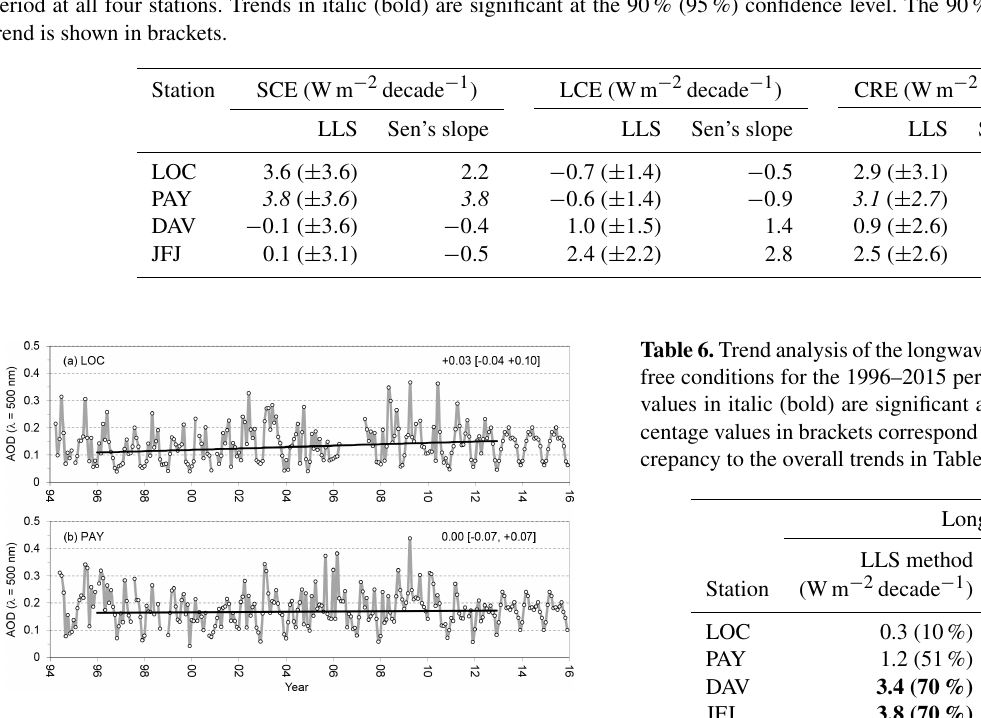
Figure 3. Time series of monthly AOD averages ( λ = 500nm) available since 1994 at (a) LOC and (b) PAY. The 1996–2012 decadal trend is shown in the top right-hand corner, where values in brackets represent the upper and lower bounds of the 90% con- fidence interval. Trend values are only calculated for observations during 1996–2013, and a climatology (1996–2012) was used for the 2013–2015 period. See text for further details.